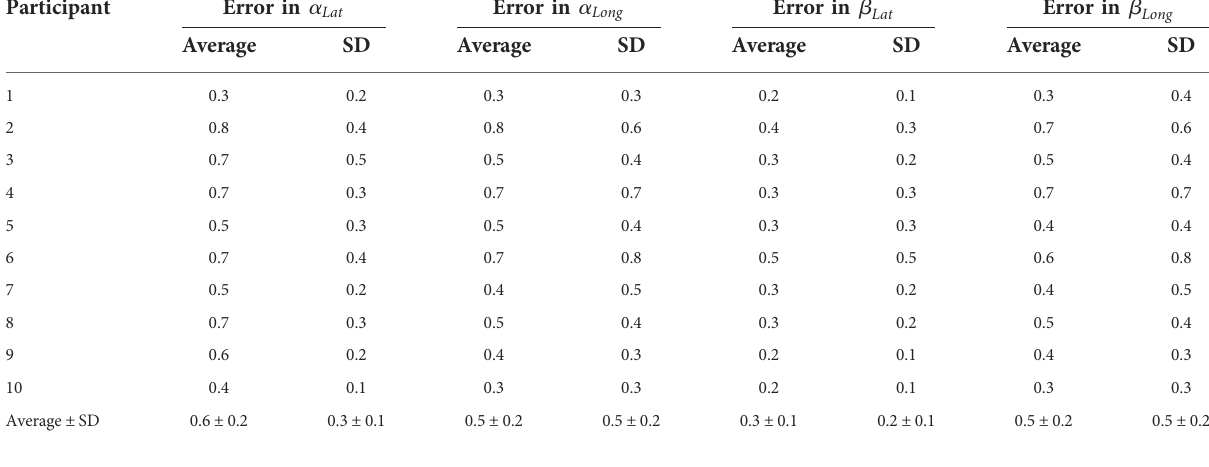
TABLE 1 Errors from manually measured three anatomical points (unit: